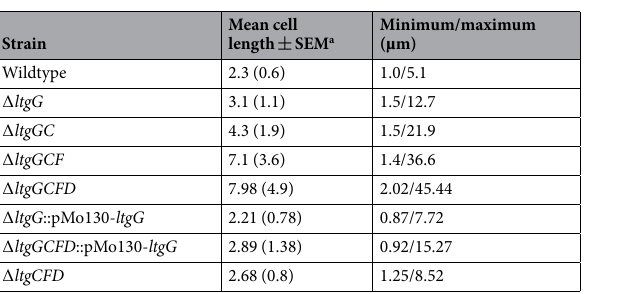
Mean cell length ± SEM a